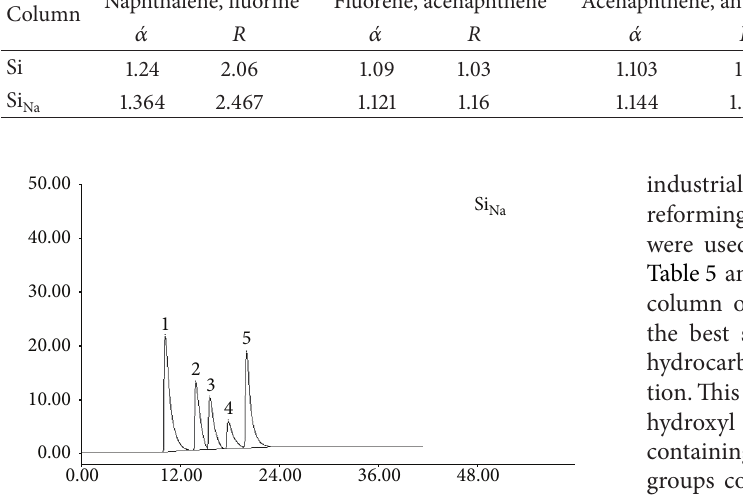
Figure 5: Gas chromatographic separation of PAHs on alkali metal modified silica as solid stationary phase, at optimum condition (temperature is 120 ∘ C; 10 ∘ C/min to 220 ∘ C for Si for others; final time